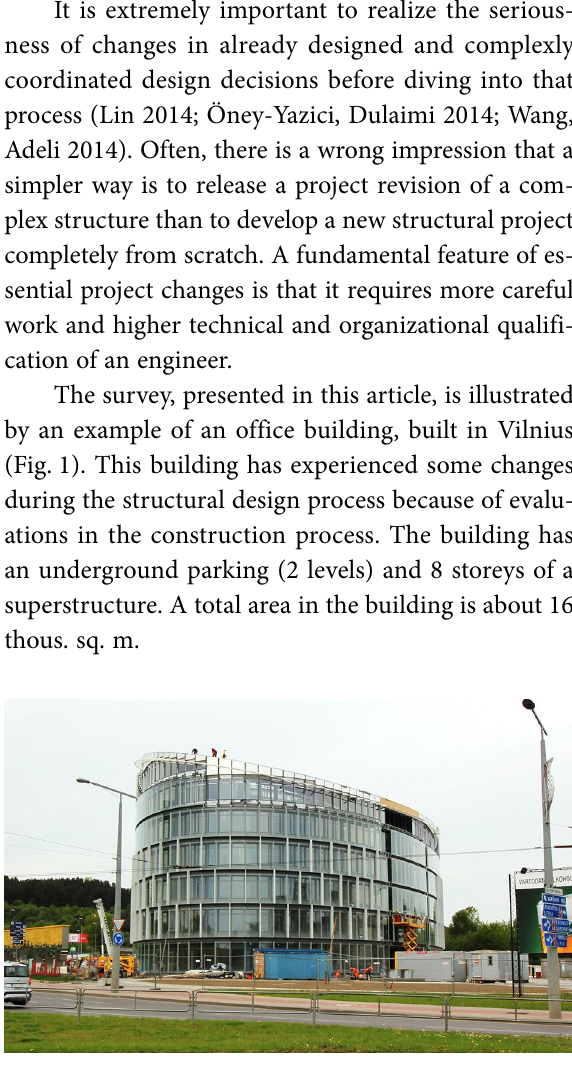
Fig. 1. An original office building,